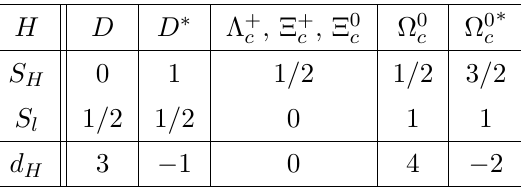
, H is zero for all three H